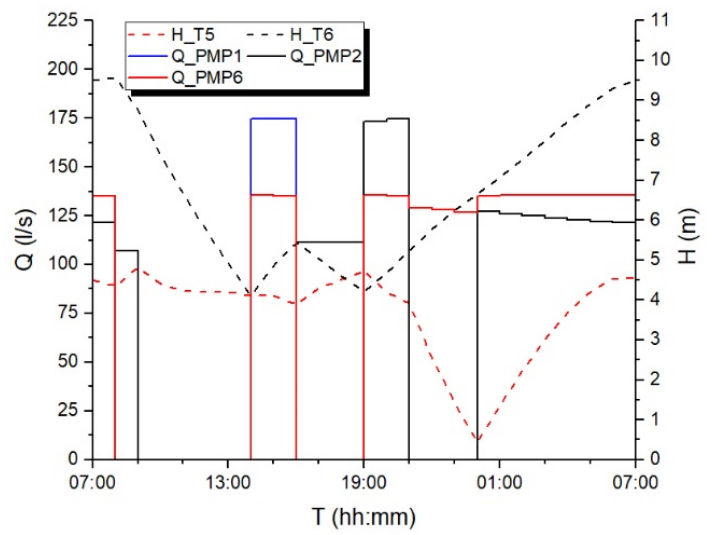
Figure 7. Results of the proposed pump scheduling methodology for Van Zyl network, hydraulic time-step 1 h.